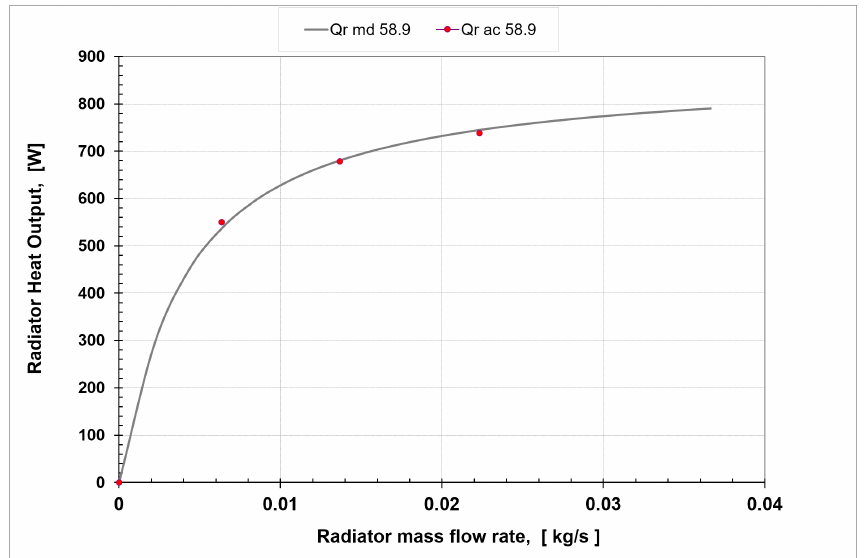
Figure 30. Comparison of test and calculations results of the convector radiator type-8RS heat output change as a function of the mass flow rate, t s = 58.9 ◦ C.